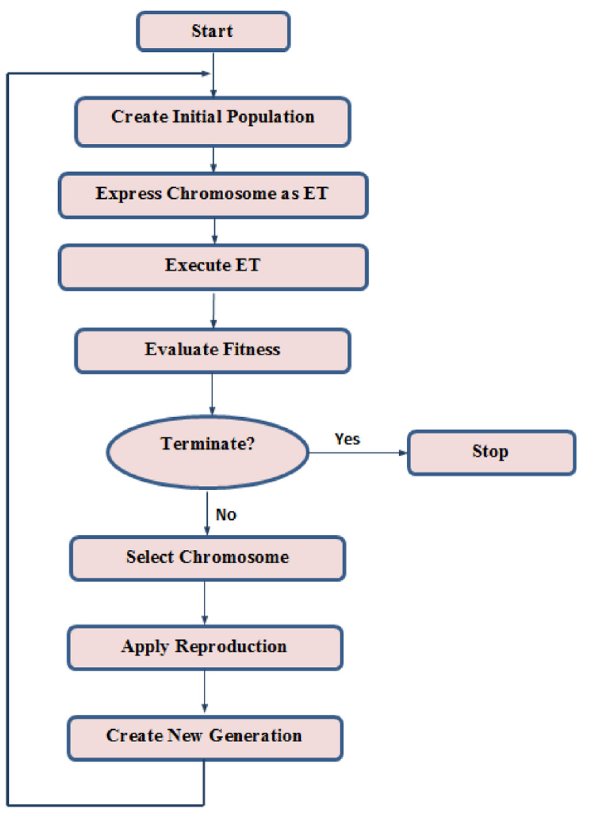
Fig. 3. Basic representation of the GEP